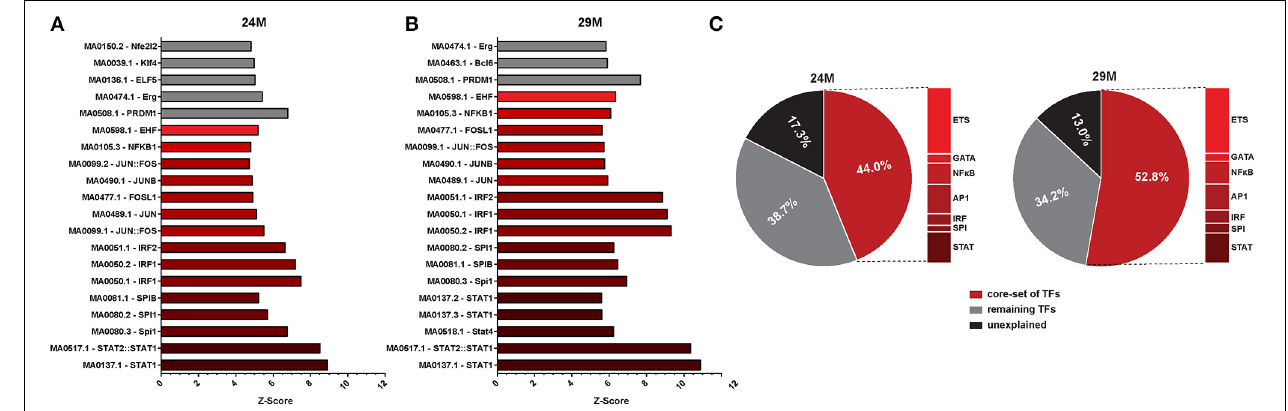
FIGURE 3 | Promoter analysis of aging-regulated genes for overrepresented transcription factor binding sites (TFBS). (A) Z-score (enrichments score) for different position weight matrices of known transcription factors in the set of gene up-regulated in 3 vs. 24-month-old mice. Higher Z-score means higher enrichment. Shown are only the top